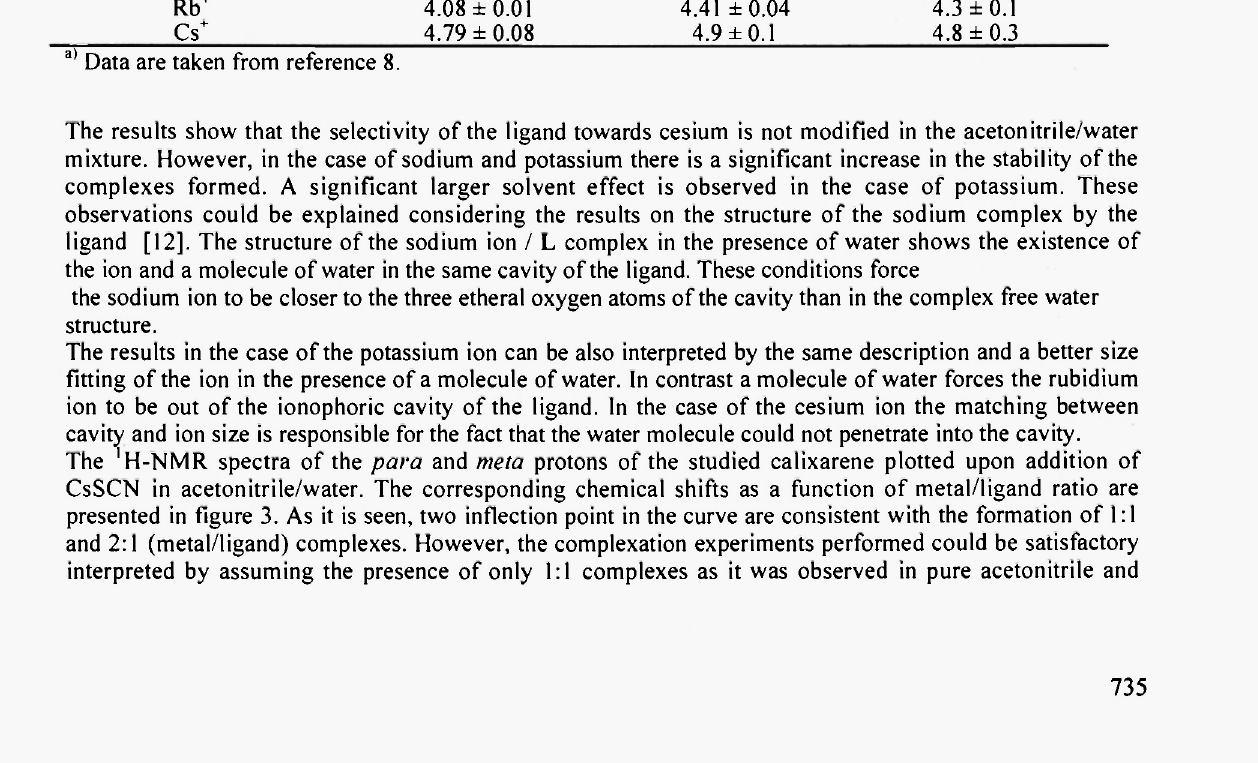
Figure 2. Change in UV absorption spectrum of L (upper curve) upon addition of CsCI in CHjCN/HiO (90/10). Table 1. Logarithms of the stability constants (β) of alkali cation complexes by